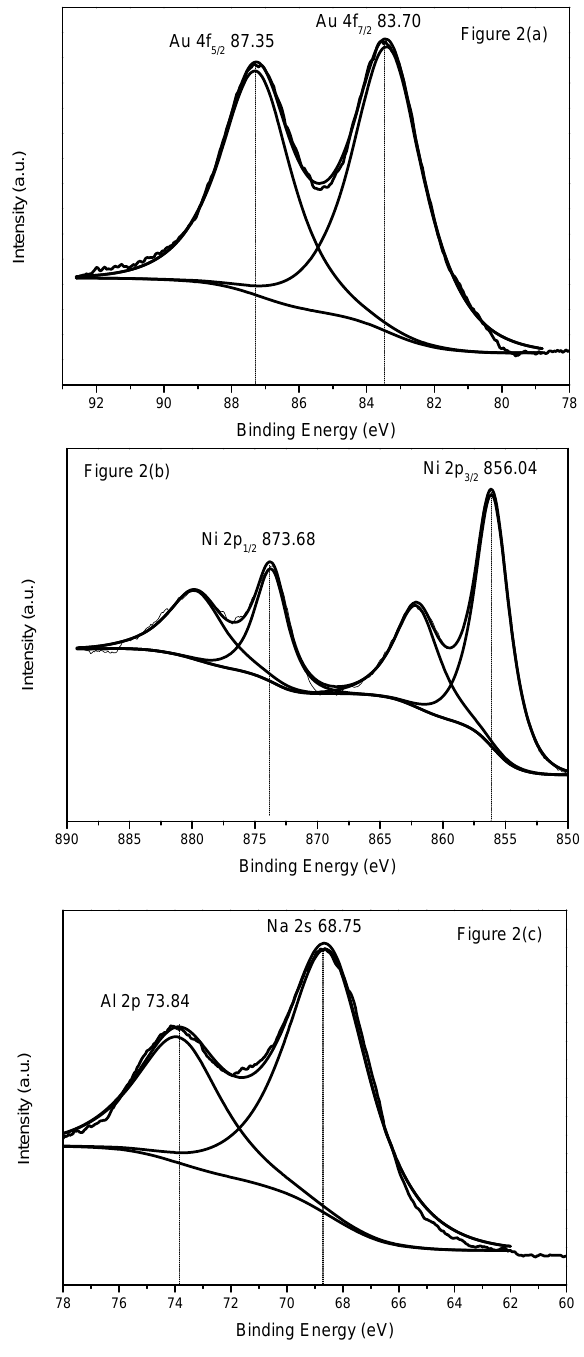
Figure 2. ( a ) XPS spectra of the Au 4f core level line for 3 wt. % Au/Ni 3 Al HT; ( b ) XPS spectra of the Ni 2p core level line for 3 wt. % Au/Ni 3 Al HT; ( c ) XPS spectra of the Al 2p core level line for 3 wt. % Au/Ni 3 Al HT.